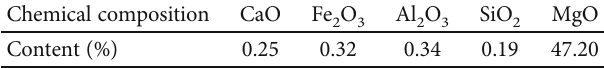
Table 1: Chemical composition analysis of magnesite. Chemical